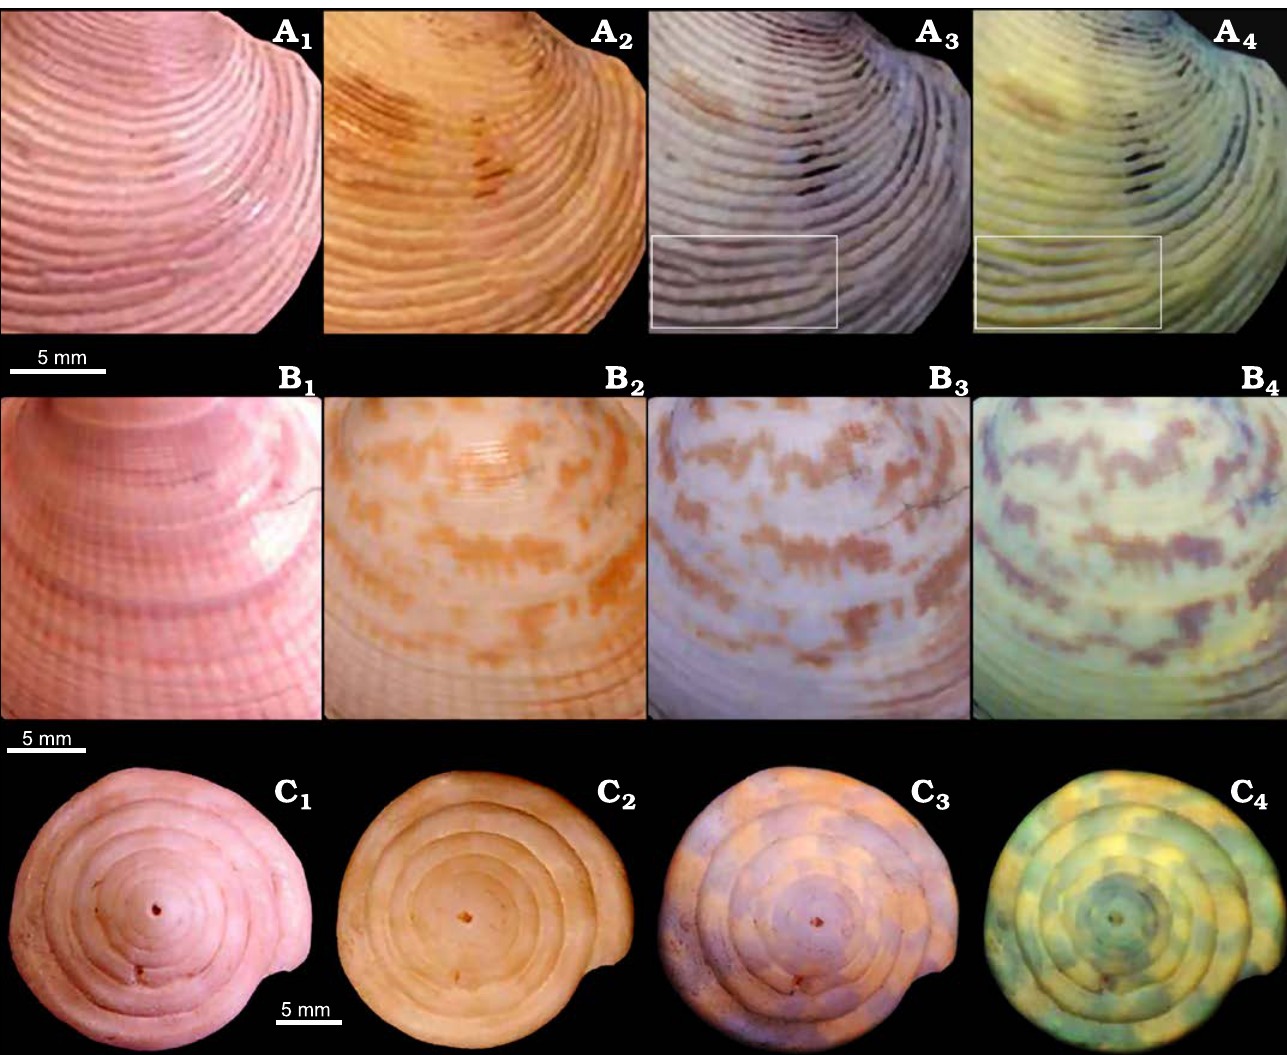
Fig. 3. Bivalves and gastropods photographed under visible, UV, and VV light. A . Venerid bivalve Chamelea gallina (Linnaeus, 1758) from the Lower Pleistocene Arda River section, Italy. MPUM 12161 (ACG204), right valve in external view. In the white rectangles is highlighted a fine zig zag colour pattern. B . Arcoid bivalve Glycymeris nummaria (Linnaeus, 1758) from the Lower Pleistocene Arda River section, Italy. MPUM 12159 (ACG204-4), left valve in external view. C . Conid gastropod Conus sp. from the Holocene Inqitat Khor Rori Archaeological Park, Oman. MPUM 12163 (BS-148) in apical view. These specimens experienced a 72 h immersion in 50% diluted bleach (MPUM 12161 [ACG204]) or pure bleach (MPUM 12159 [ACG204-4], MPUM 12163 [BS-148]). Visible light, without treatment (A 1 –C 1 ); visible light, bleach treatment (A 2 –C 2 ); 365 nm, bleach treatment (A 3 –C 3 ); 440 nm, bleach treatment (A 4 –C 4